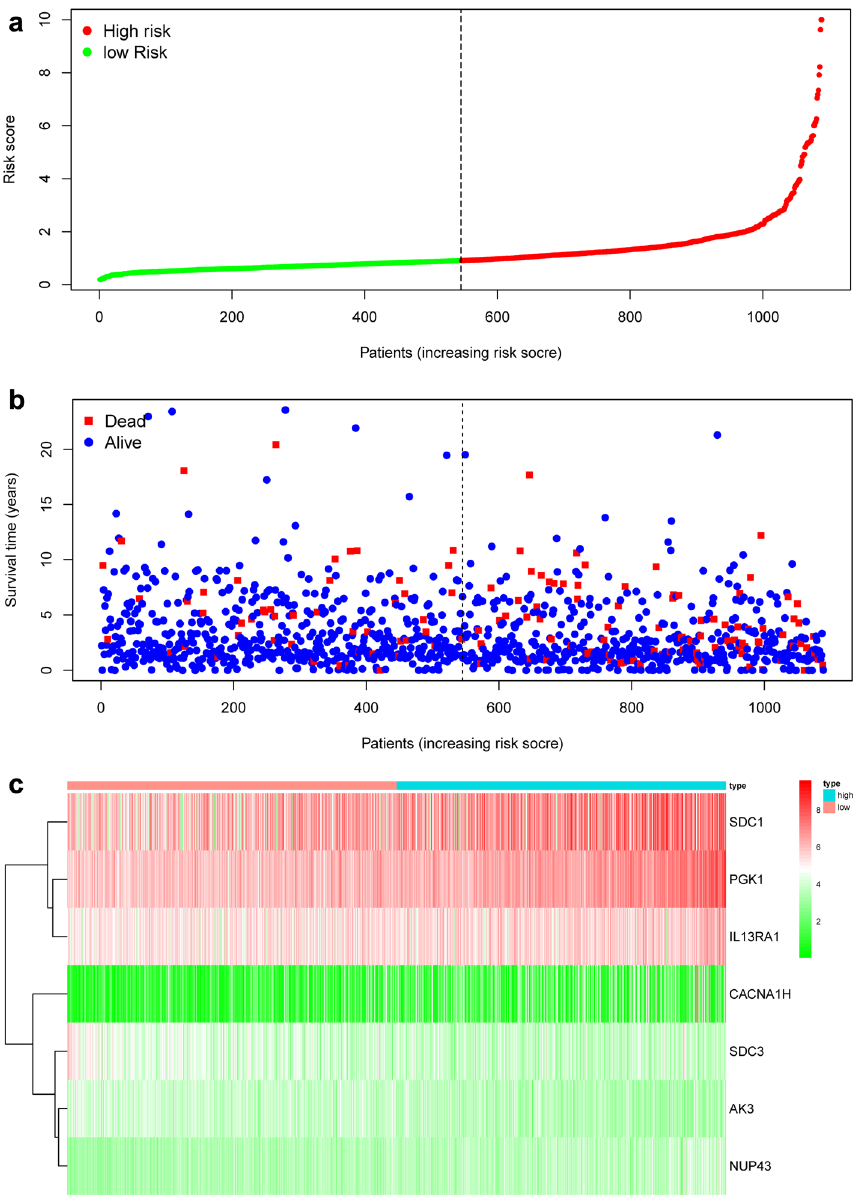
Figure 3. The risk parameter-associated seven-mRNA signature predicts OS in patients with breast cancer. ( a ) The distribution of risk parameter of mRNA in each patient. ( b ) Survival days of BC patients with increasing risk parameters. ( c ) A heatmap of the expression profile of seven genes. Red indicates upregulated genes and light green indicates downregulated